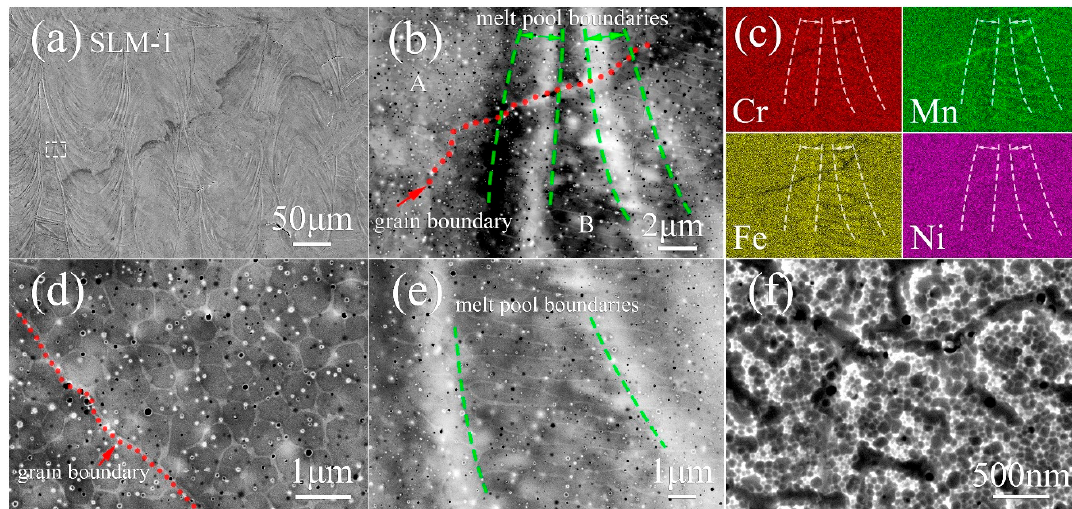
Figure 3. SEM observation on the XY-plane of SLM-1 CrFeNiMn alloy. The SE images of ( a ) melt pool assemblages; ( b ) detailed microstructure with ( c ) the corresponding quantitative SEM-EDS maps of elemental distribution; ( d ) equiaxed cells; ( e ) elongated cells; ( f ) ultrafine sub-cells. The micrographs in ( d ) and ( e ) present the typical magnified morphology of area A and B in ( b ), respectively.